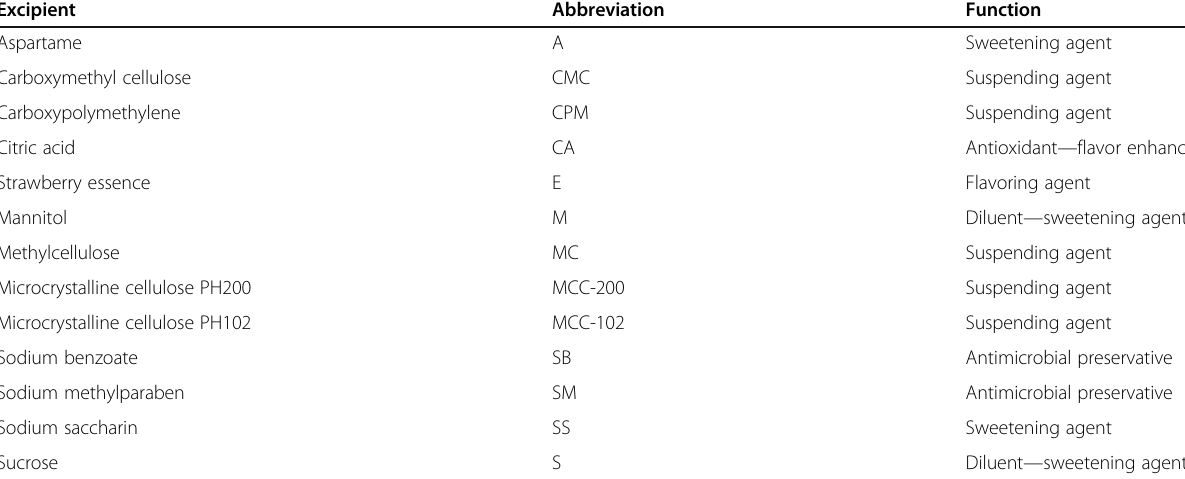
Table 1 Excipients for extemporaneous suspensions